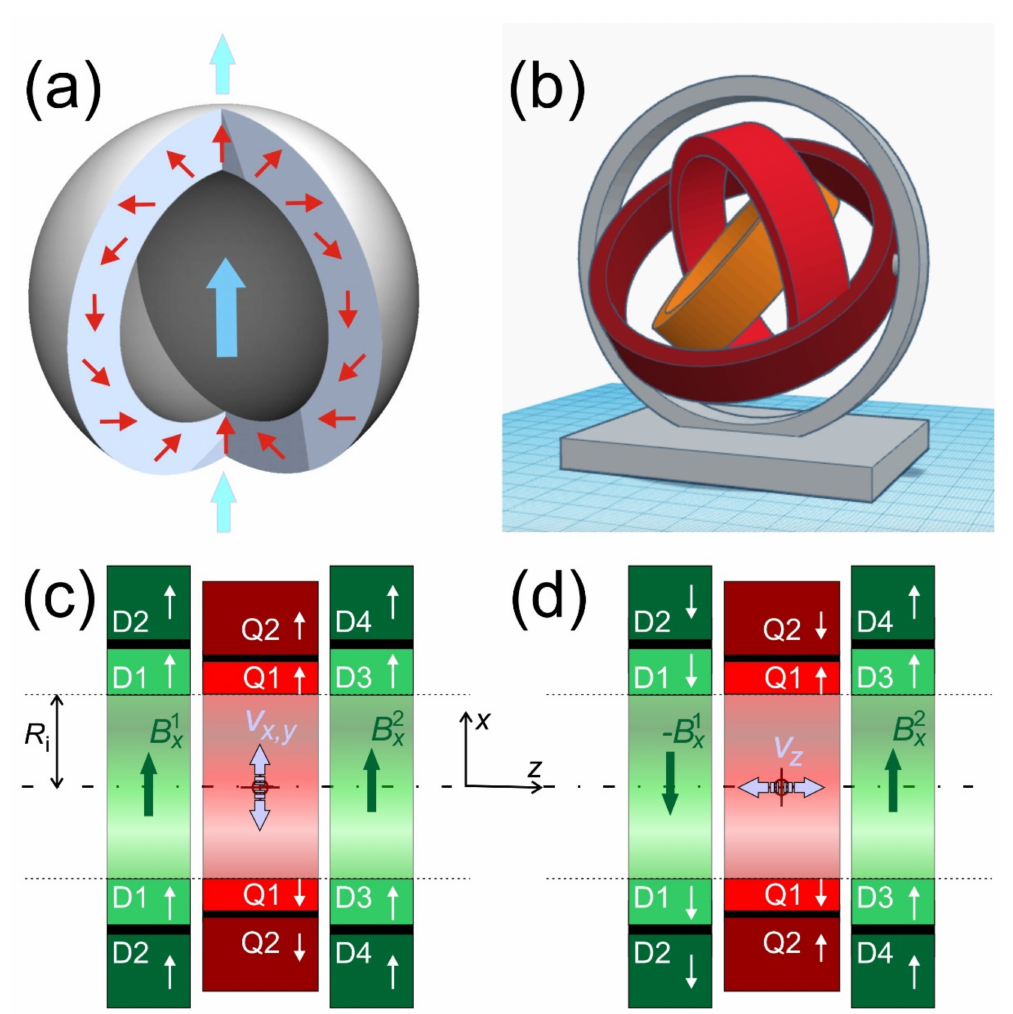
Figure 7. Three-dimensional guiding ideas: ( a ) A Halbach sphere is made by rotating a Halbach cylinder around the axis through the poles. The magnetic field inside is 4/3 higher than in an ideal Halbach cylinder, but it also produces stray fields (small vertical arrows). ( b ) Sketch of 3D gimbal gantry. ( c ) Axial cross-section through a magnet system of two pairs of dipoles (green) and two quadrupoles (red). The dipoles and quadrupoles could for instance be concentric Halbach cylinders, here displayed as axial slices. The dipoles are split in a pair to homogenize the field in the center. If the strength of D1 = D3 and D2 = D4 the system is described in Section 3 and analyzed in Appendix D. In the shown configuration, objects are oriented in the x -direction and moved in the central xy -plane (lilac arrows). ( d ) Adding one additional degree of freedom to the system in ( c ) by independently rotating the left and right dipoles. If the quadrupoles are put in a cancelling position and the dipoles are in opposite directions, a gradient along the z -direction (axis) is generated. This system is discussed in Appendix E. If the guided object moves, then with v z the container (e.g., patient) should be moved via a stage with − v z so that the object stays in the